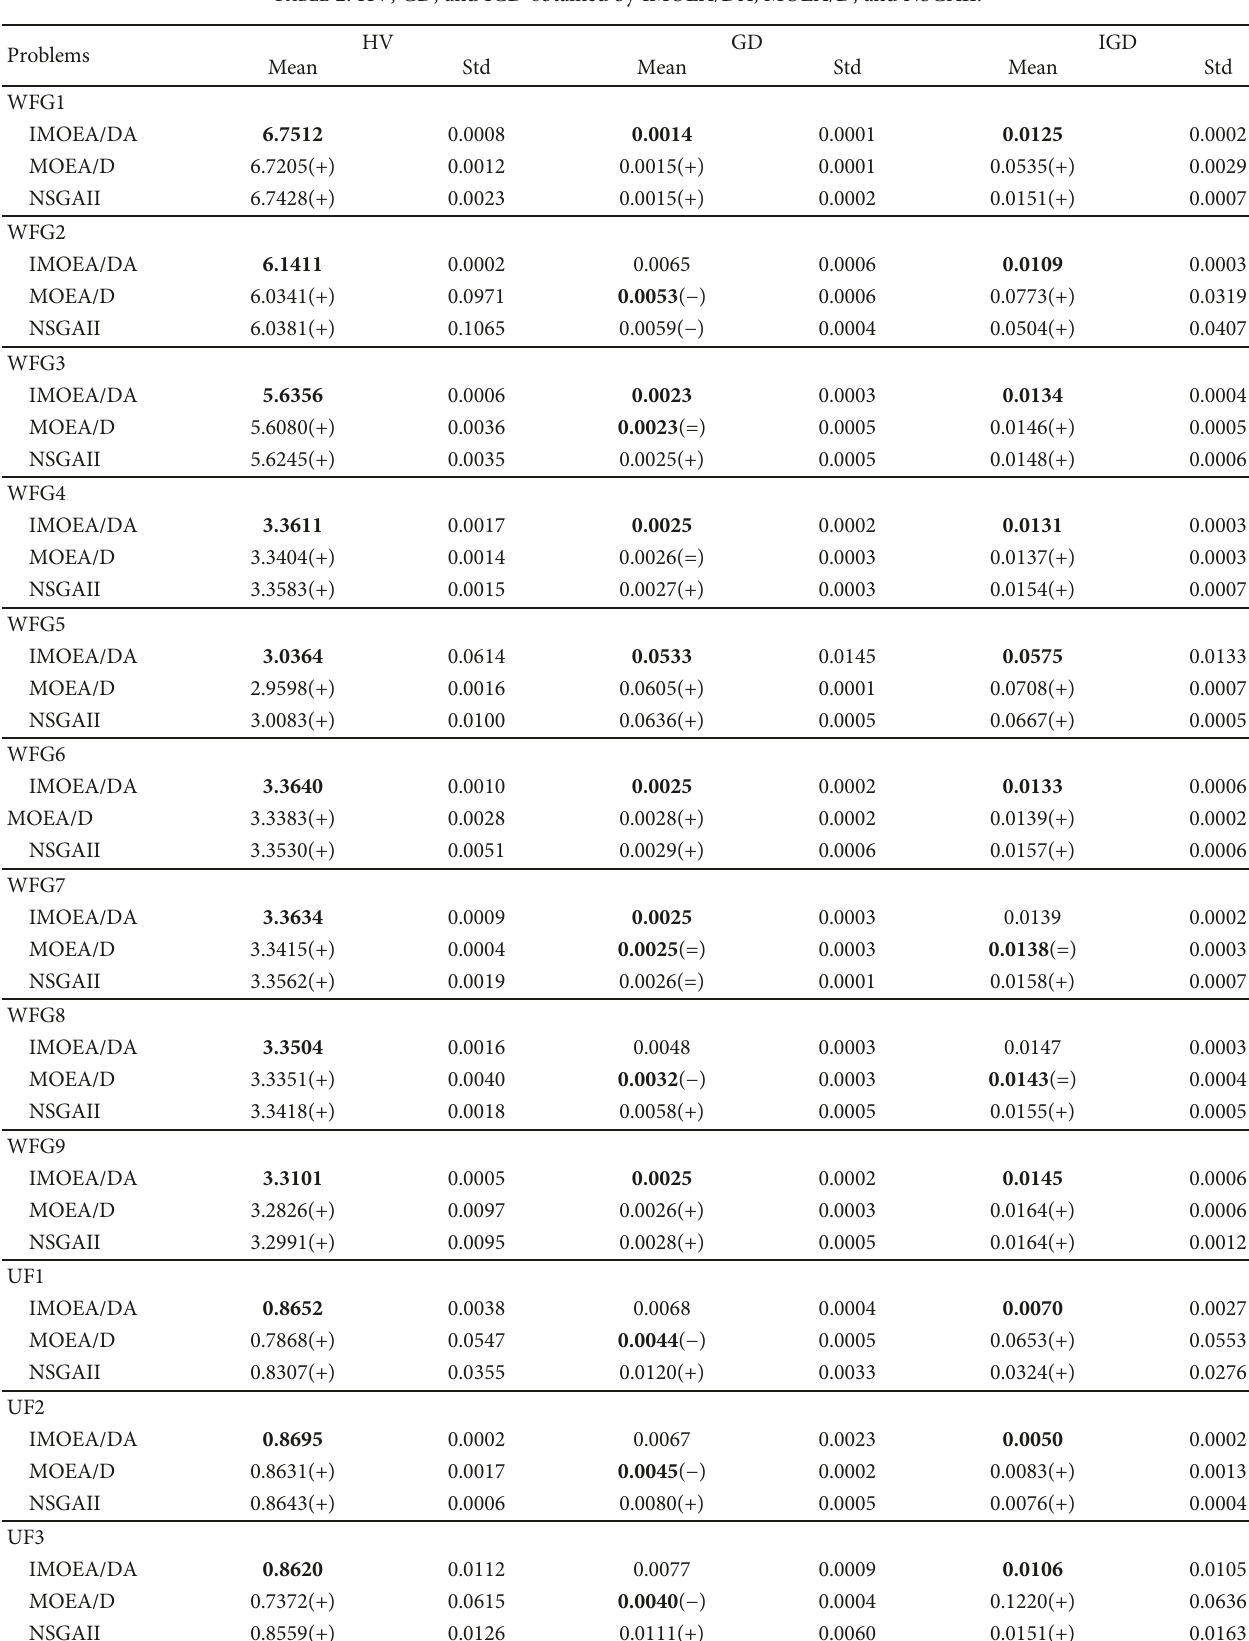
Table 2: HV, GD, and IGD obtained by IMOEA/DA, MOEA/D, and